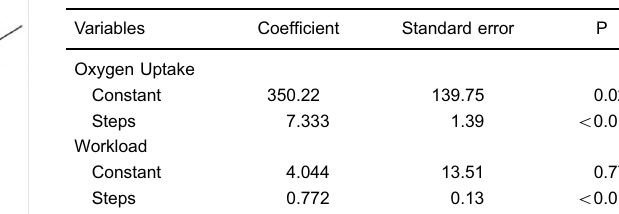
Table 4 . Predictive model of peak oxygen uptake and workload in the cardiopulmonary exercise test (CPET).